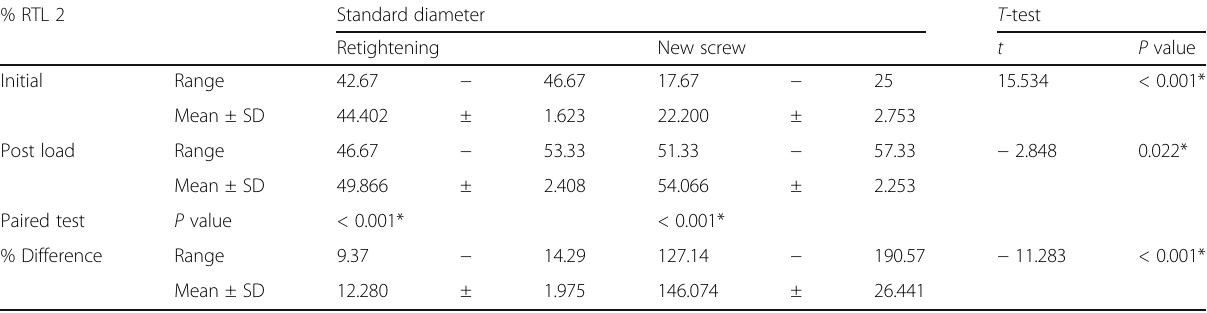
Table 4 Mean ± SD of percentage initial and percentage post load RTL 2 and percentage difference between initial and post load RTL 2 for GIA and GIB % RTL